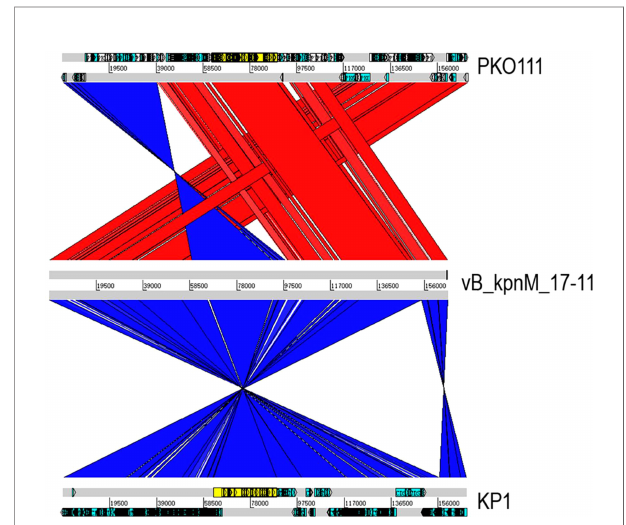
FIGURE 6 | Multiple genome alignments of phage vB_kpnM_17-11, PKO111 and KP1. Red and blue represent the forward and reverse matches, respectively. The darker the color, the higher